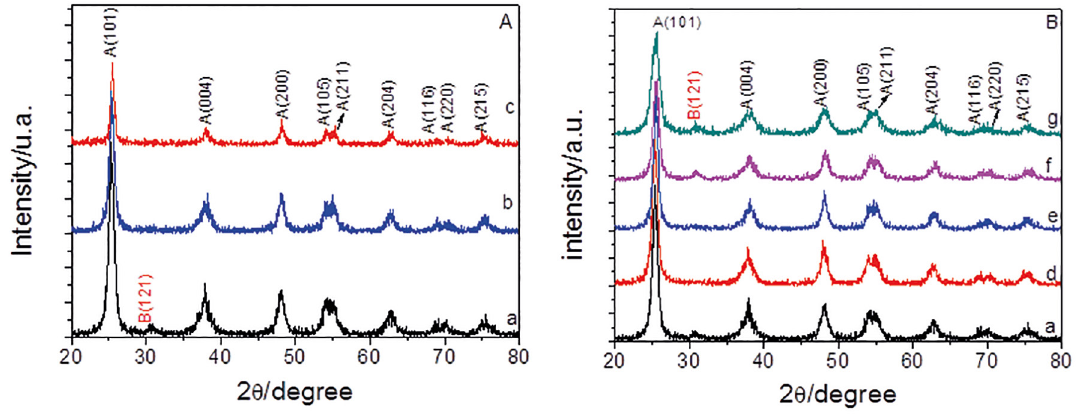
samples. (A) Reflux syntheses: (a) TO, (b) ATO-1, and (c) ATO-2; (B) autoclave syntheses: (a) Figure 3. XRD patterns of different TiO 2 TO, (d) RTO-2, (e) RTO-4, (f) RTO-5, and (g)